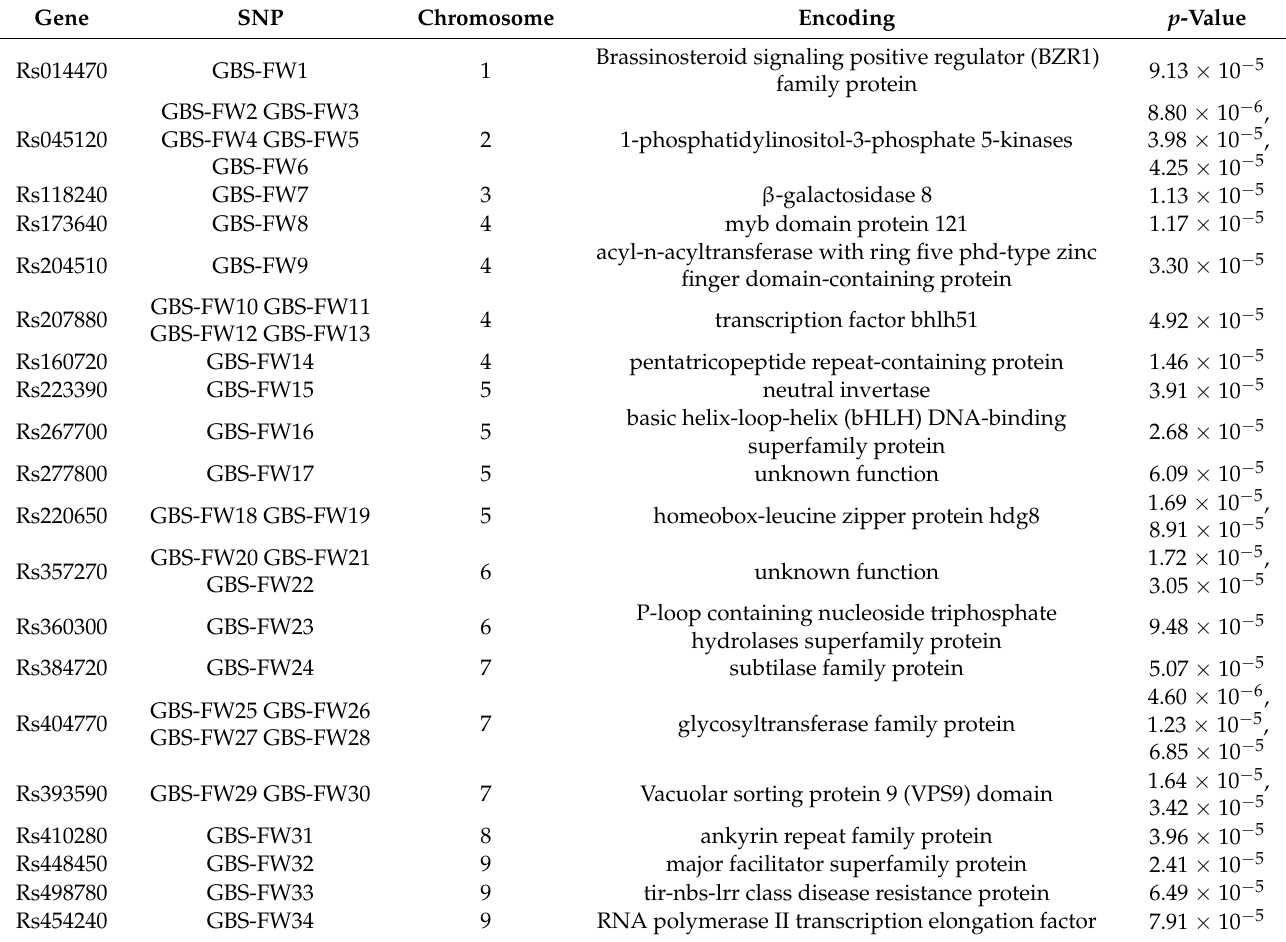
Figure 3. Manhattan plots of radish SNP markers mapped on nine chromosomes of R. sativus using mixed model (Q + K). Table 1. Potential candidate genes related with Fusarium wilt resistance detected by